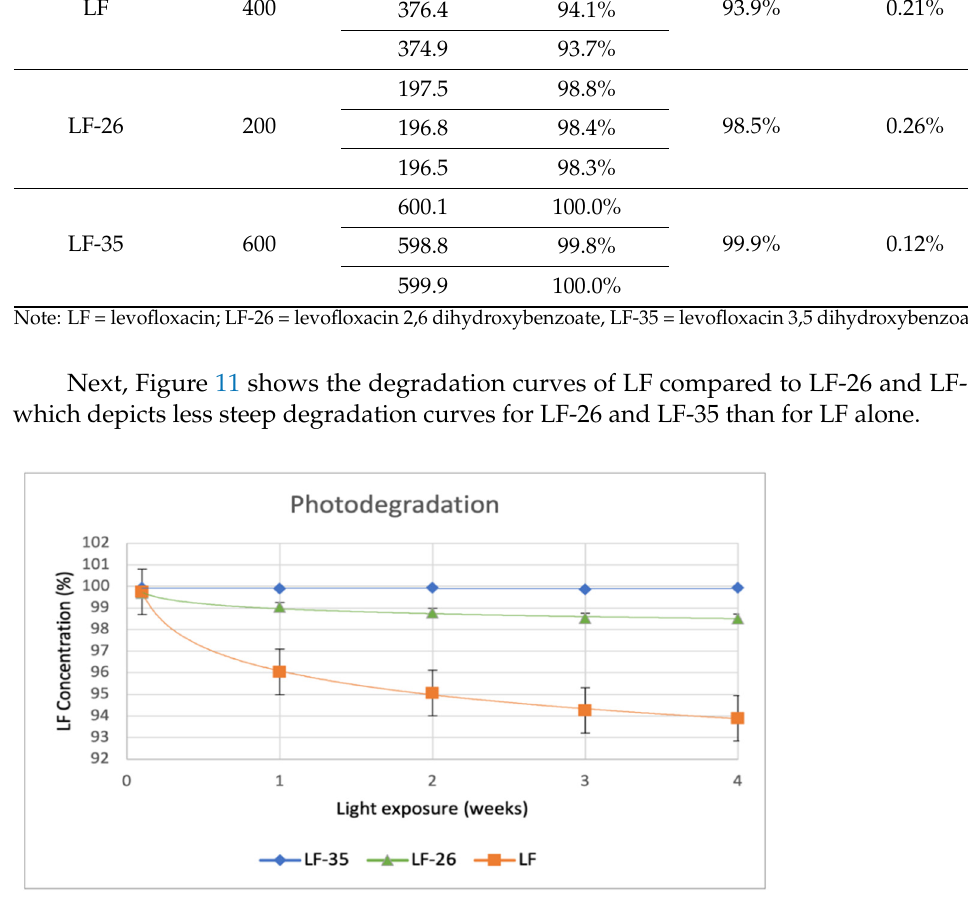
Figure 11. Photodegradation graph of LF, LF-26, and LF-35 for the 4-week stability test period. Note: LF = levofloxacin, LF-26 = levofloxacin 2,6 dihydroxybenzoate, LF-35 = levofloxacin 3,5 dihydroxybenzoate.